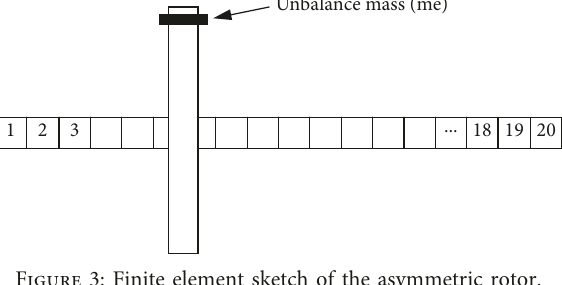
Figure 3: Finite element sketch of the asymmetric rotor.